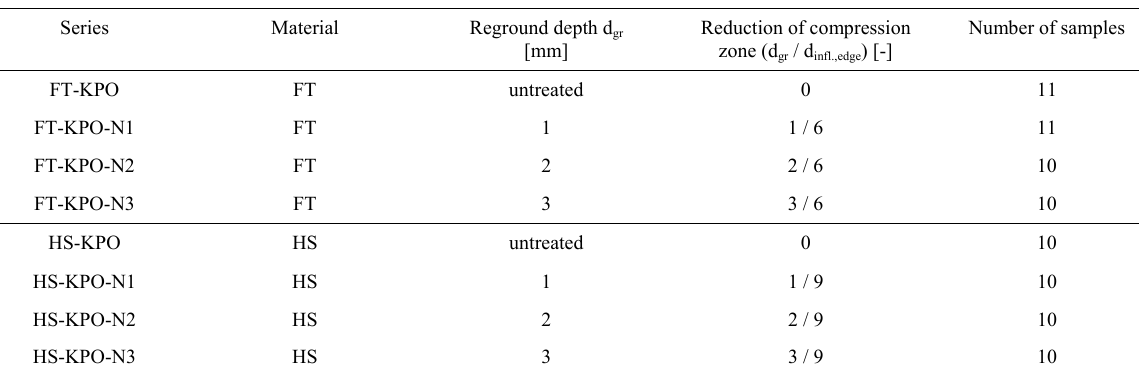
Table 2: Experimental test series